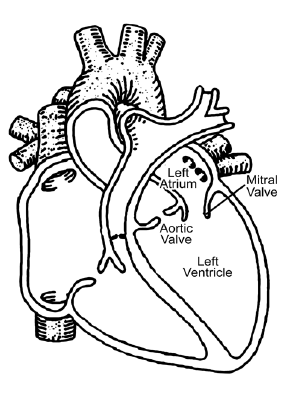
Figure 1: Basic anatomy of the heart.